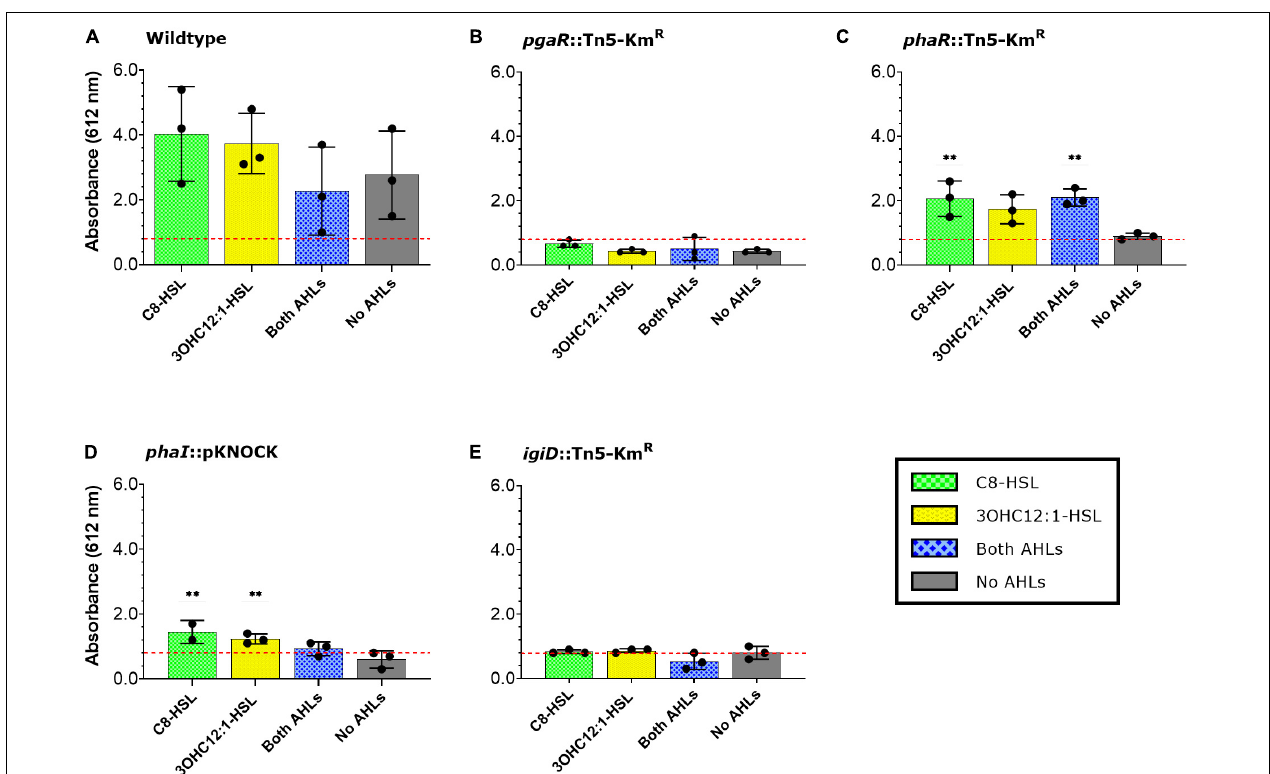
FIGURE 2 | Indigoidine production in response to growth-phase dependent AHL exogenous addition. Indigoidine quantification in Y4I variants: WT (A) , pgaR ::Tn5-KM R (B) , pgaR ::Tn5-KM R (C) , phaR ::pKNOCK (D) , and igiD ::Tn5-Km R (E) following exogenous addition of AHLs, as indicated in the legend. Indigoidine quantification was normalized to biomass and compared to no a AHL control in the igiD ::Tn5-Km R mutant (red dotted line). Error bars represent standard deviations from the mean of three biological replicates. Statistical significance was calculated by comparing AHL treatments to the no AHL control within strain genotypes. Asterisks represent statistical difference ( p <